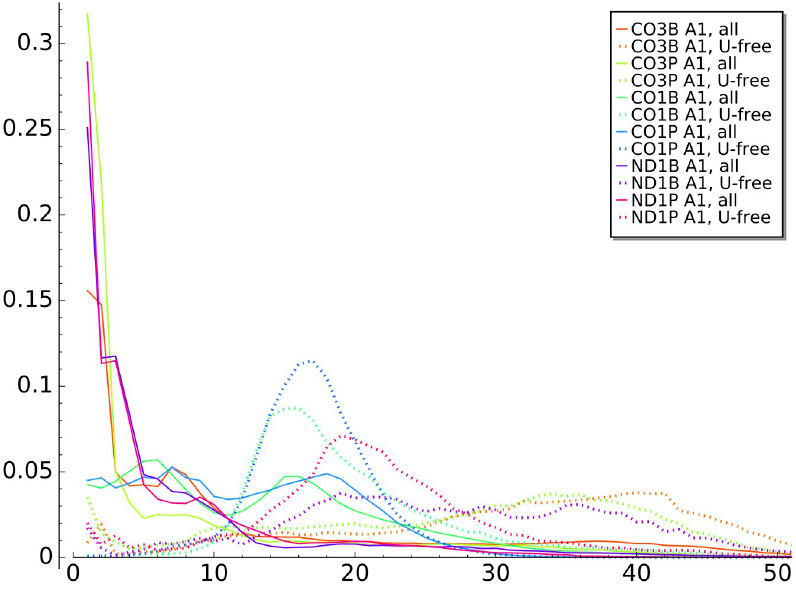
Fig 4. Initial A-homopolymer distributions. Distribution of initial A-homopolymer lengths for tail populations of all analyzed transcripts (solid lines) and poly(A) tail-only sub-populations (dotted lines) for each transcript tail dataset.